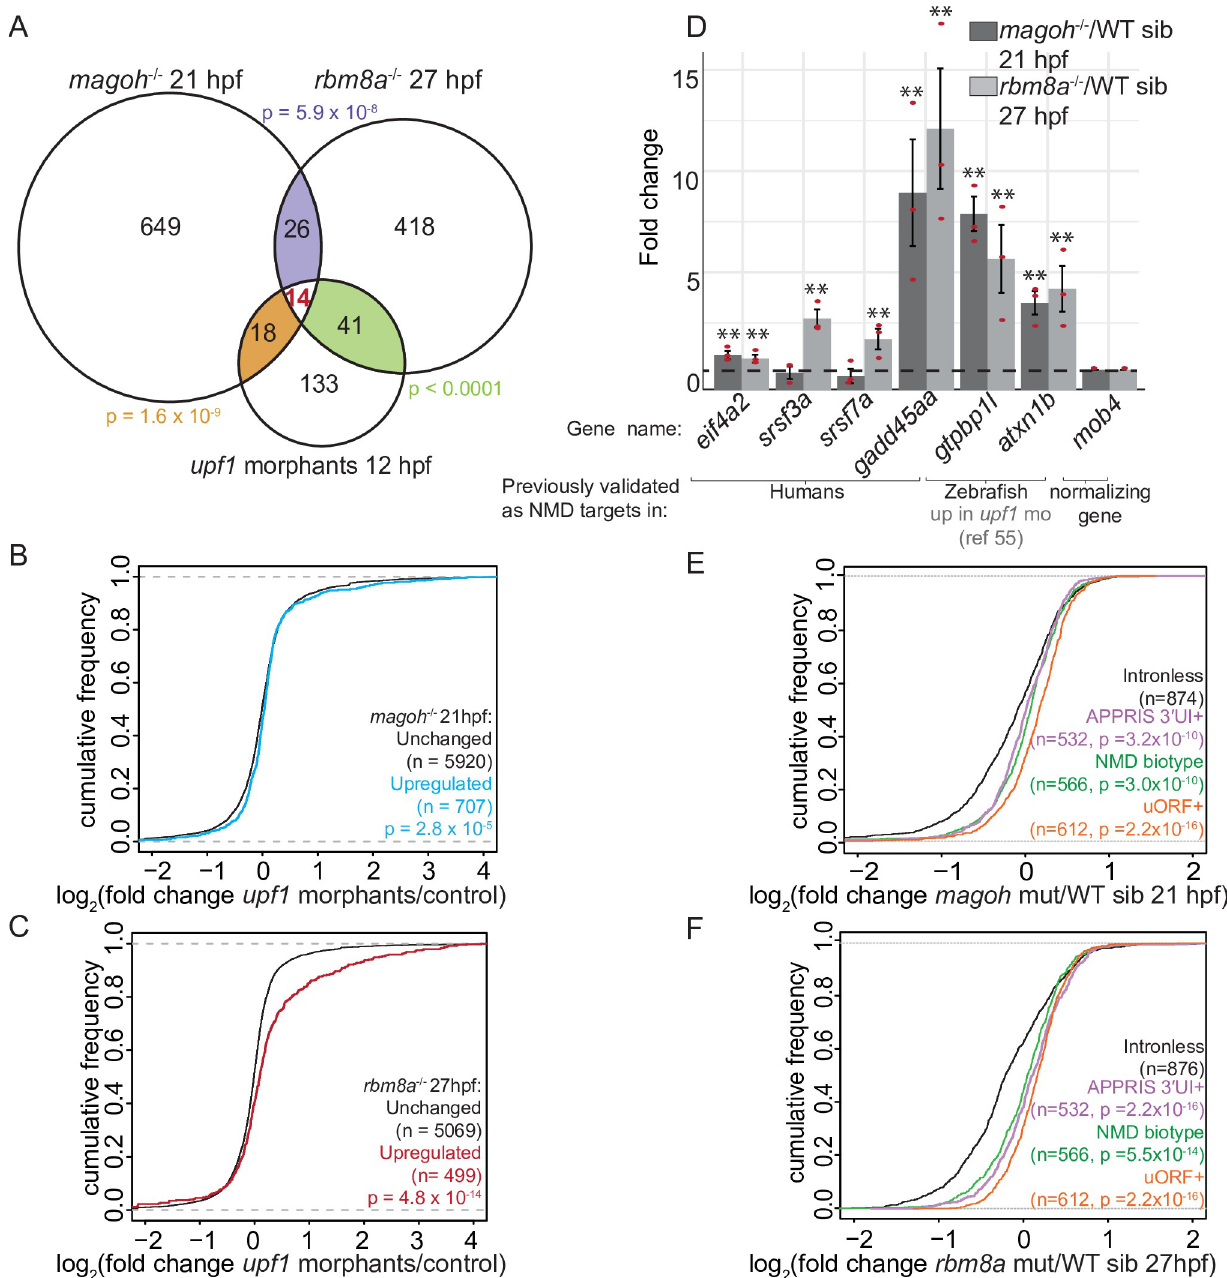
Fig 5. Genes upregulated in EJC mutant embryos are also regulated by Upf1 and contain NMD-inducing features. A. Venn diagram showing the overlap of significantly upregulated genes in EJC mutant embryos and upf1 morphants. Each overlap and its corresponding hypergeometric test-based p- value are color-coded. B. Cumulative distribution frequency (CDF) plot shows the empirical cumulative distribution of the fold changes in upf1 morphants (12 hpf) for genes upregulated (blue) and unchanged (black) in magoh mutant embryos at 21 hpf. The empirical CDF is the proportion of all values less than or equal to the total number of observations in the group. The CDF function shown here and in all subsequent figures (except Fig 7D) is plotted as an increasing step function along the y-axis with a jump of 1/N at each value of gene number equal to an observed value of fold change (mutant/ WT) (x-axis). Thus, the group of genes that show a rightward shift along the x-axis when compared to control group of genes is a measure of their upregulation in mutants compared to WT siblings (x-axis label). Kolmogorov-Smirnov (KS) test p-value for differences in fold changes between the two groups is indicated on the bottom right. C. CDF plot as in B for genes upregulated in rbm8a mutant embryos at 27 hpf (red) compared to unchanged genes (black). D. Quantitative RT-PCR (qRT-PCR) analysis showing fold change of select NMD target transcripts (x-axis) compared to control ( mob4 ) transcript in magoh mutant embryos at 21 hpf compared to wild-type siblings (dark gray bars) and in rbm8a mutant embryos at 27 hpf compared to wild- type siblings (light gray bars). The selected genes either contain a 3 0 UTR intron ( eif4a2 , srsf3a and srsf7a ) and/or have orthologs that are known NMD